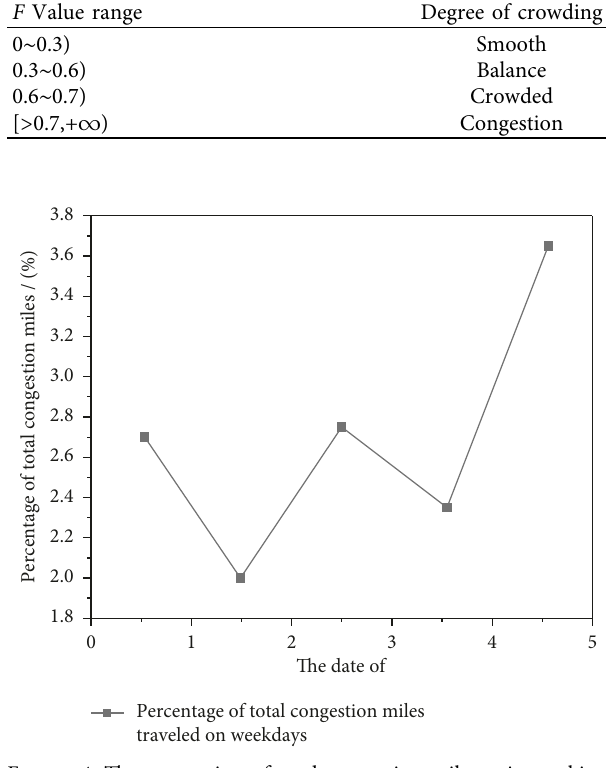
Figure 4: The proportion of total congestion mileage in working days.